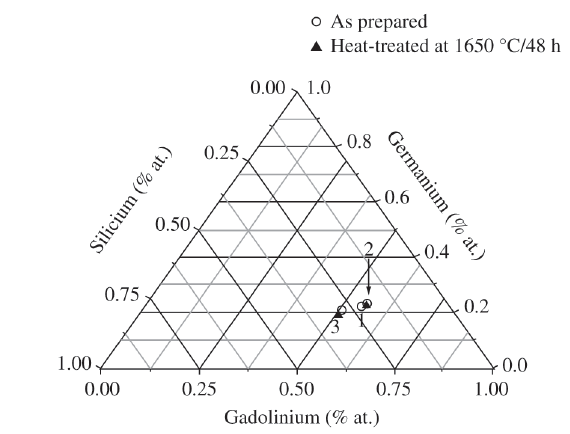
Figure 1. Ternary diagram representation of the composition of phases measured by microprobe analyses for the as-prepared al- loy and heat-treated alloy, where (1) is the global composition of the alloys, (2) is the matrix phase and (3) represents the minority phase.